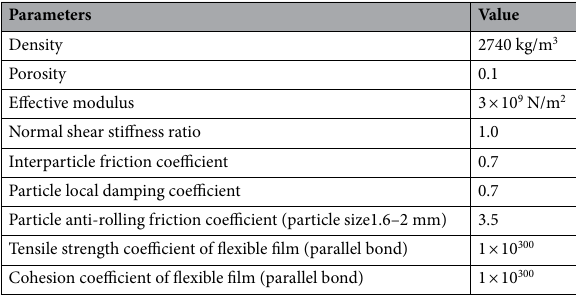
Table 4. Some micro parameters adopted in DEM